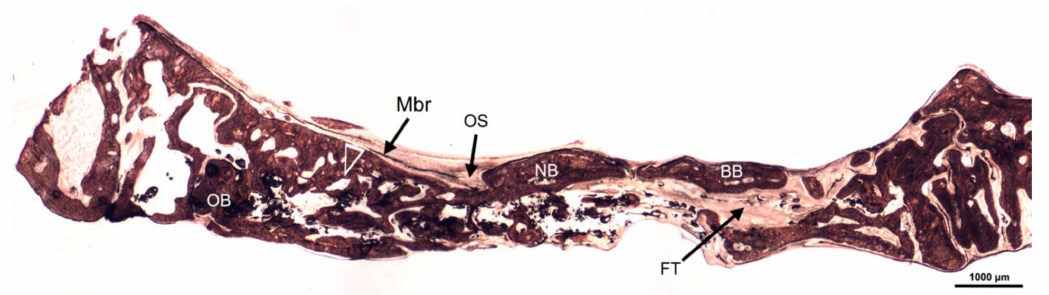
Figure 10. Bone histomorphometry obtained by dye with Von Kossa silver nitrate stain to visualize formed mineralized bone in experimental animals at six weeks of follow-up, around Zn-loaded membranes. Trabecular bone formations were formed along the margin of calvarial defect and within the defect (arrow head). Bony bridging (BB), Fibrous tissue (FT), Membrane (Mbr), Osteoid (OS), Old bone (OB).